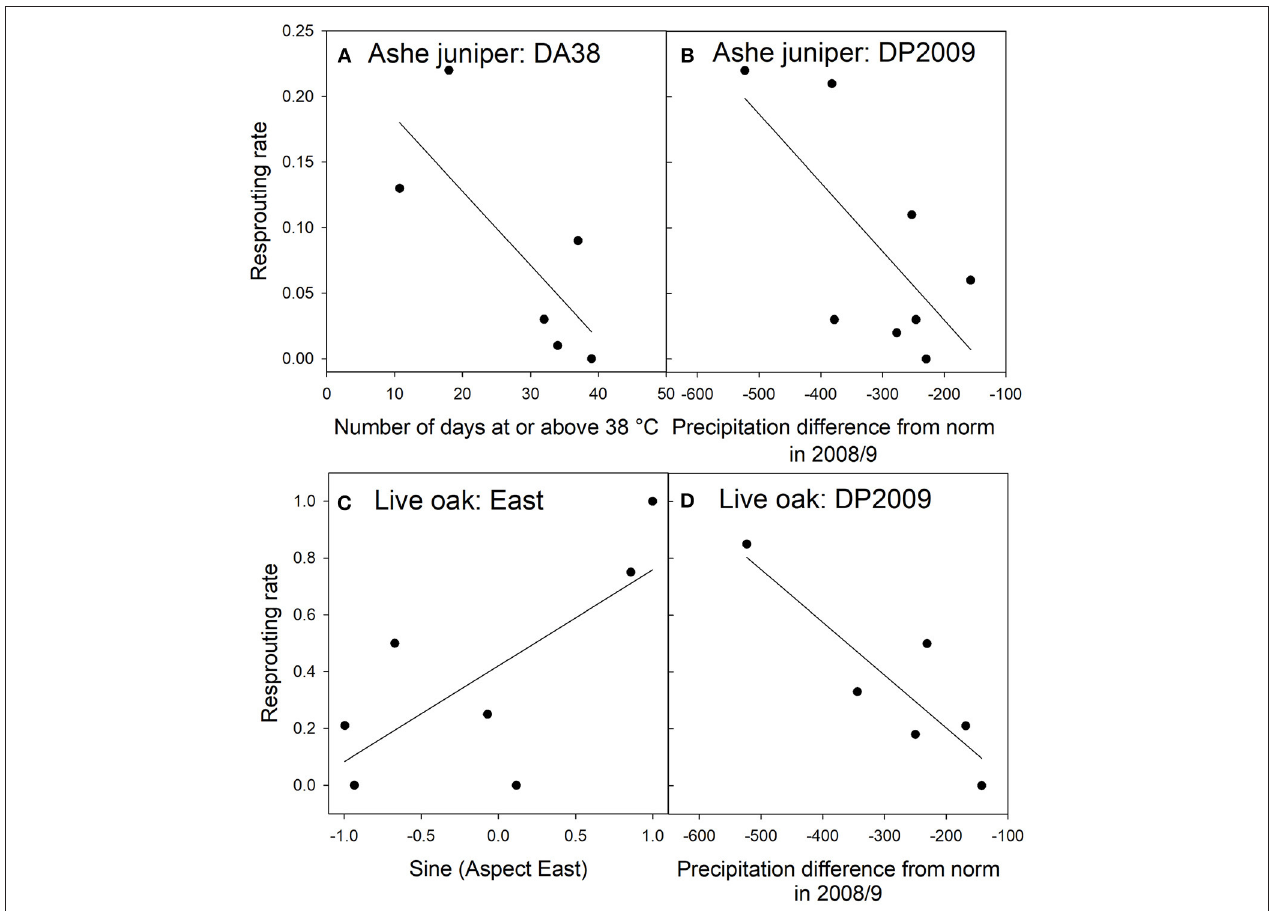
FIGURE 6 | Relationships between resprouting rates and environmental factors in Ashe juniper (A,B) and live oak (C,D) in the top regression models RJ1 and RO1. The environmental factors were divided into classes with approximately equal membership and class averages were plotted on the x-axis. There are as many classes as the granularity of the data allowed. See Table 2 for an explanation of variable